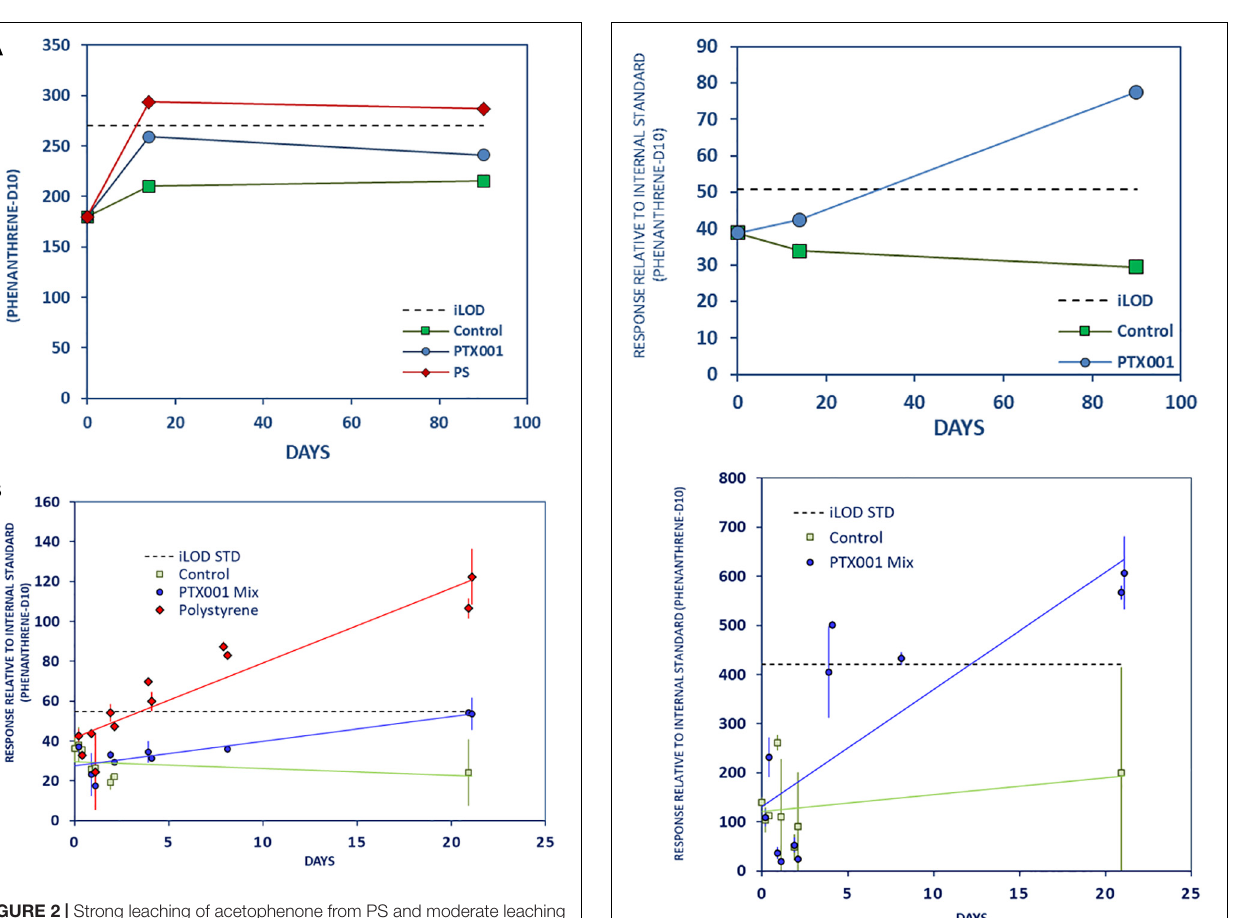
FIGURE 2 | Strong leaching of acetophenone from PS and moderate leaching from PTX001 to stomach oil. (A) long-term experiment (LTE) with connecting lines and (B) short-term detail experiment (STD) with linear trendlines and standard deviations. Both lines are only used for visualization of data and do not imply that leaching patterns are linear.